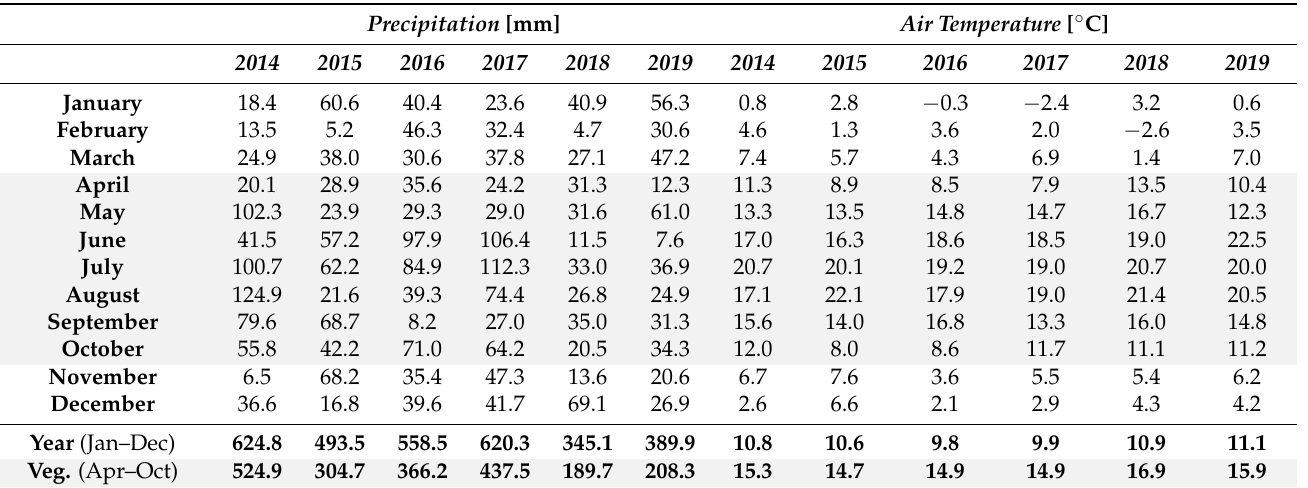
Table 4. Monthly sum of rainfall [mm] and average air temperature [ ◦ C] throughout the years 2014–2019. Data recorded at FIB weather station Welzow , Brandenburg, Germany. The background colour is a stylistic